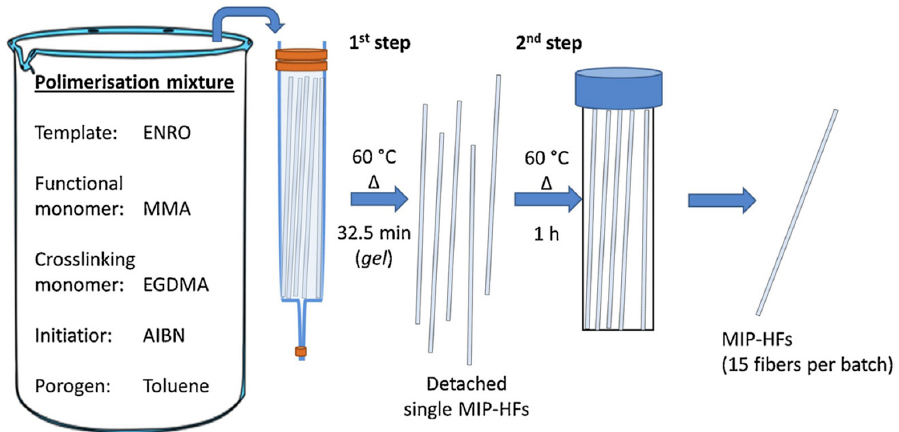
Figure 8. Scheme of the two-step polymerization procedure for the preparation of MIP-HFs. Reprinted from [42], with permission from Elsevier, 2019.